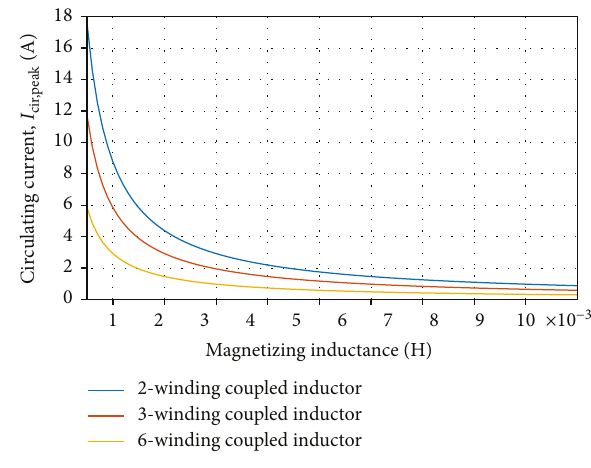
Figure 21: Peak circulating current versus magnetizing